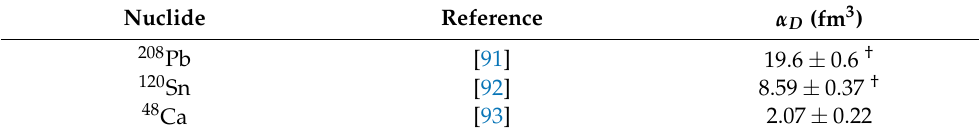
Table 6. Dipole polarizabilities with 1 σ uncertainties. † α D values corrected as per Ref. [90].